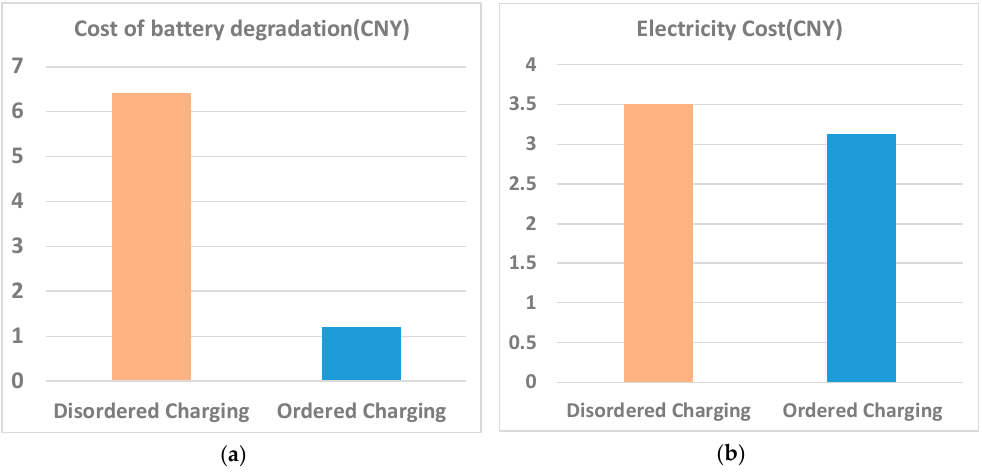
Figure 7. Operating cost comparison of one time charging: ( a ) costs of battery capacity degradation comparison; and ( b ) electricity costs comparison.